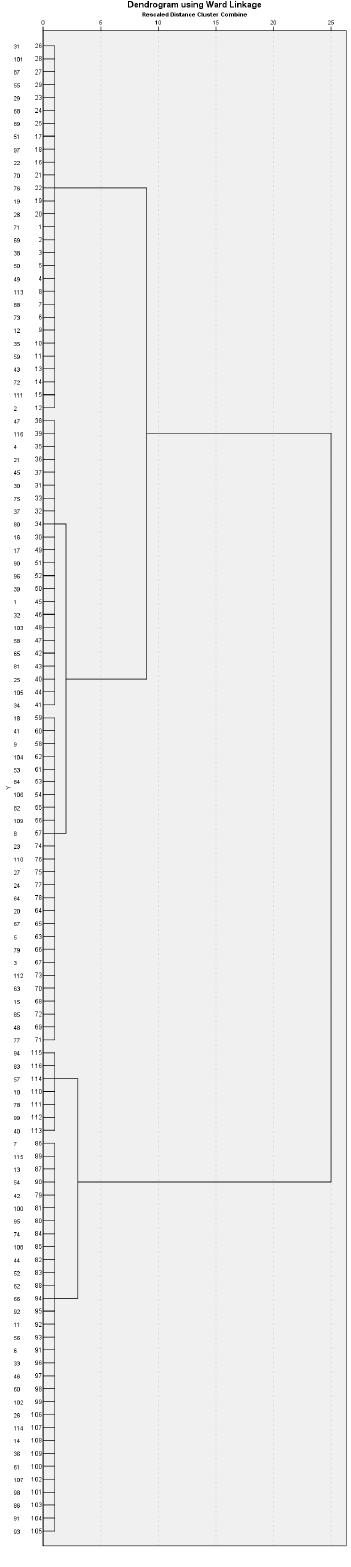
Figure A1. Dendrogram of Hierarchical Cluster Analysis of Reaction Time.